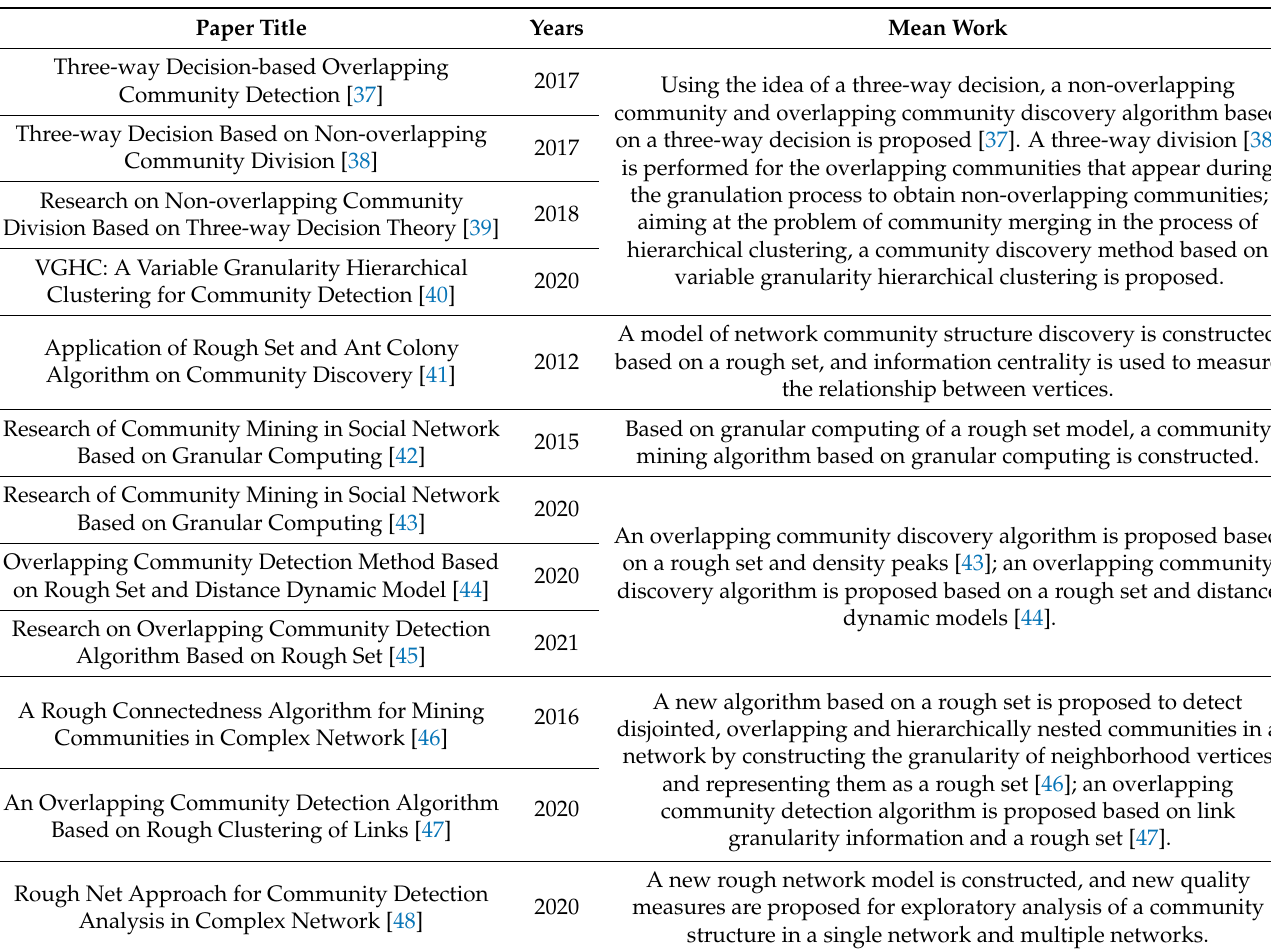
Table 3. Modeling of rough sets in community